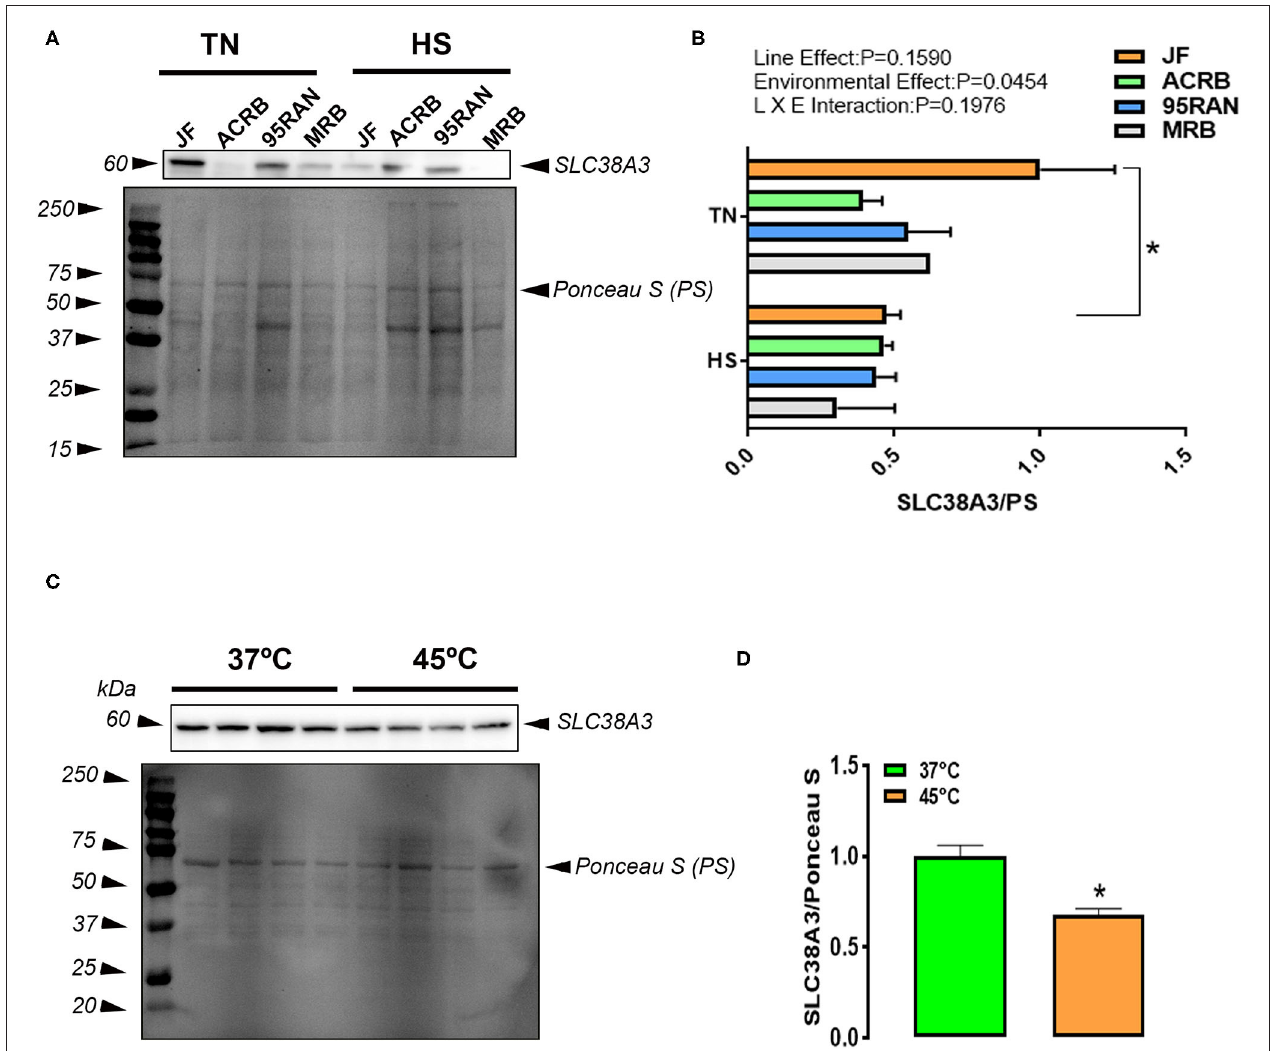
FIGURE 6 | Amino acid transporter protein expression in the jejunum of JF, ACRB, 95RAN, and MRB birds under TN and HS and in IPEC-J2 cell line. Protein was extracted from tissue and cells exposed to HS (45 ◦ C) or to 37 ◦ C (control) and analyzed by western blot (A–D) . Protein expression was normalized to loading via Ponceau stain (PS) (A,C) . Protein was analyzed via AlphaView software and is expressed as mean ± SEM ( n = 4/group) for IPEC-J2 cells and ( n = 4/group) for tissue. *indicate a significant difference compared to TN conditions for bird populations or 37 ◦ C for IPEC-J2 cell line at P < 0.05. HS, heat stress; TN,